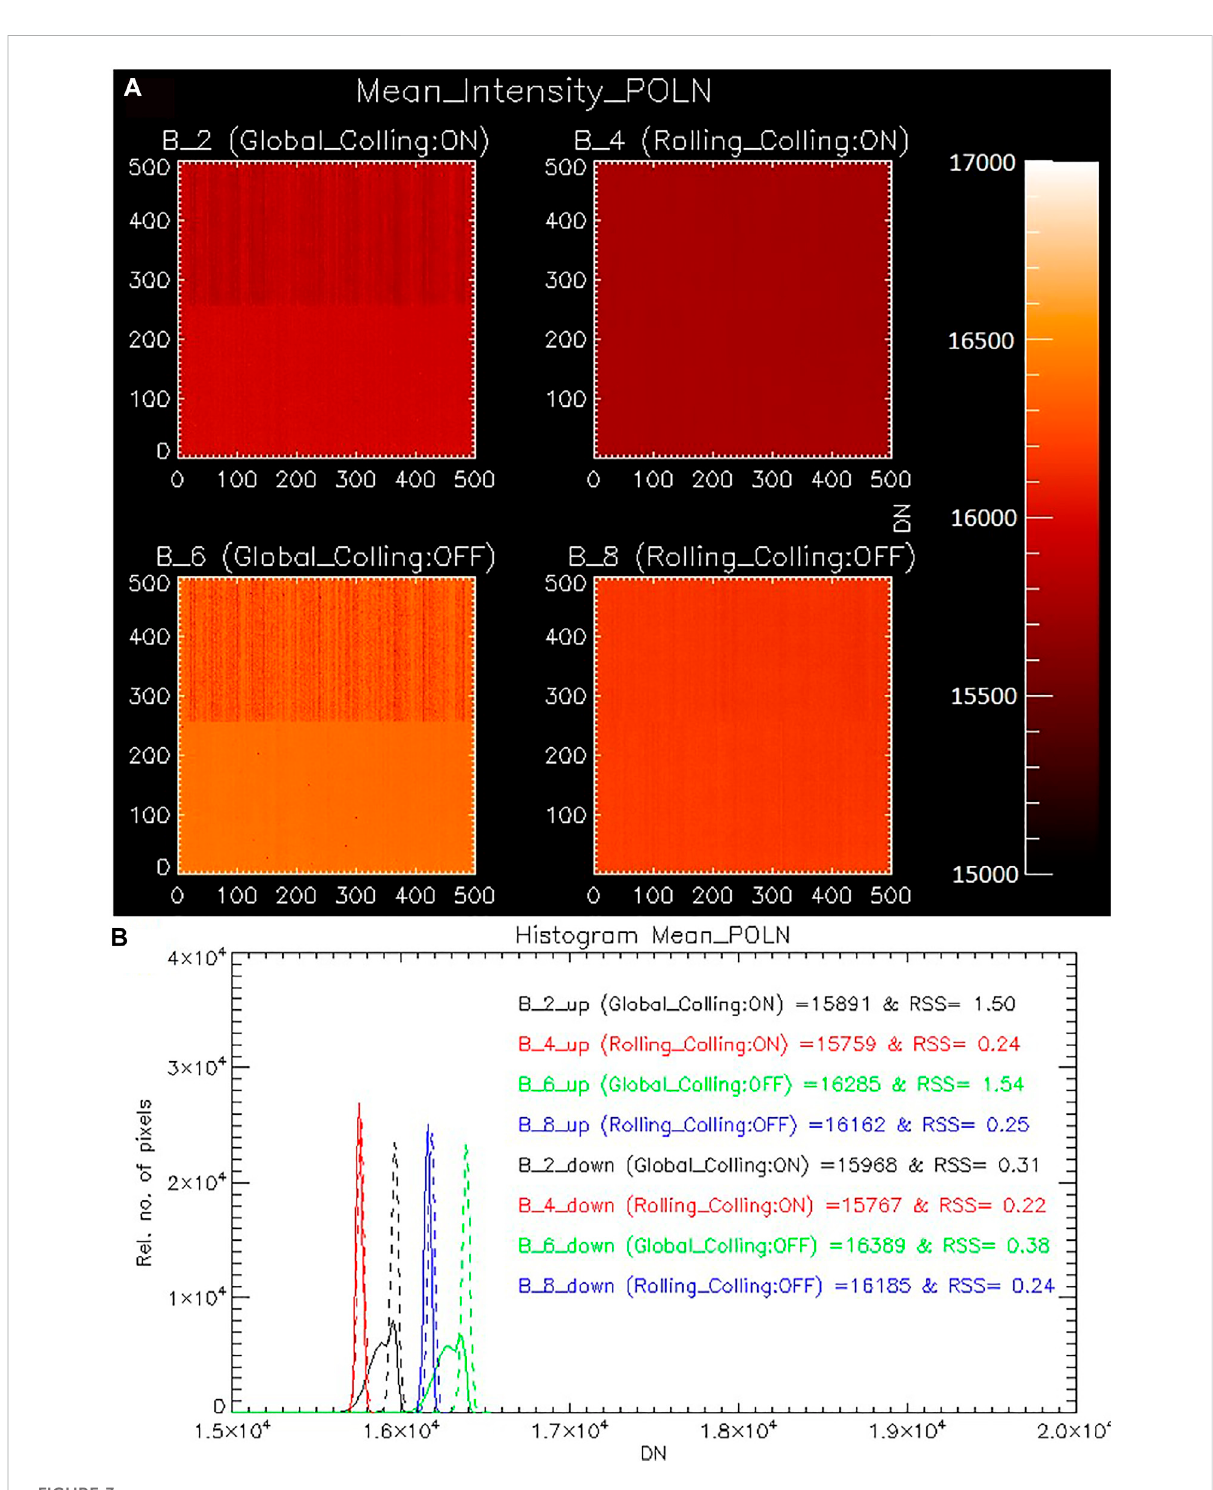
FIGURE 3 Comparison between Shutter types (Global and Rolling) and cooling. Average of ten different exposure times. Data acquired without a reference polarizer (POLN). Blocks 2 and 6 are from Global Shutter and blocks 4 and 8 are from Rolling Shutter. B2 and B4 have the cooling ON, B6 and B8 do not. Panel (A) 2D plots, panel (B) histograms. The data is split between the two halves of the sensor in the histogram. The solid line represents the sensor ’ s top (up), and the dashed line represents its bottom